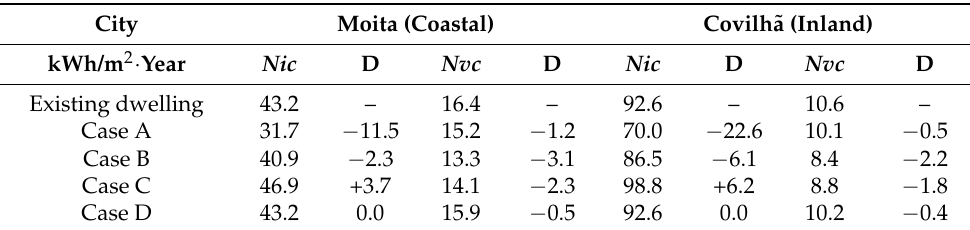
Table 4. Nic and Nvc results for the existing dwelling and considering each envelope constructive retrofit